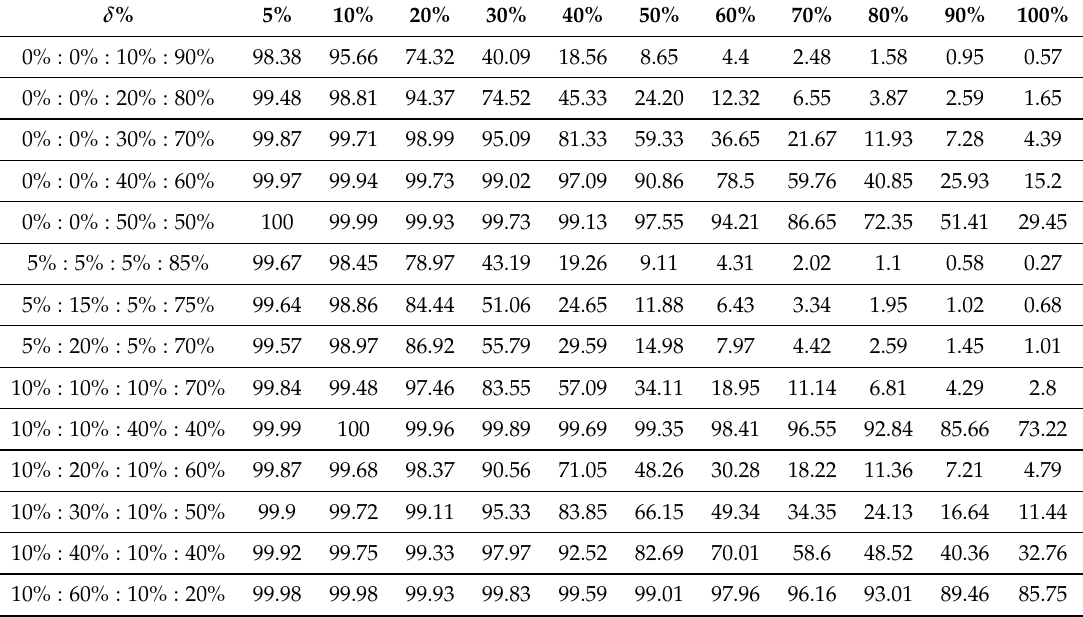
Table 2. Average percentages of the instances whose optimality of the constructed permutations was proven at the off-line and on-line phases of